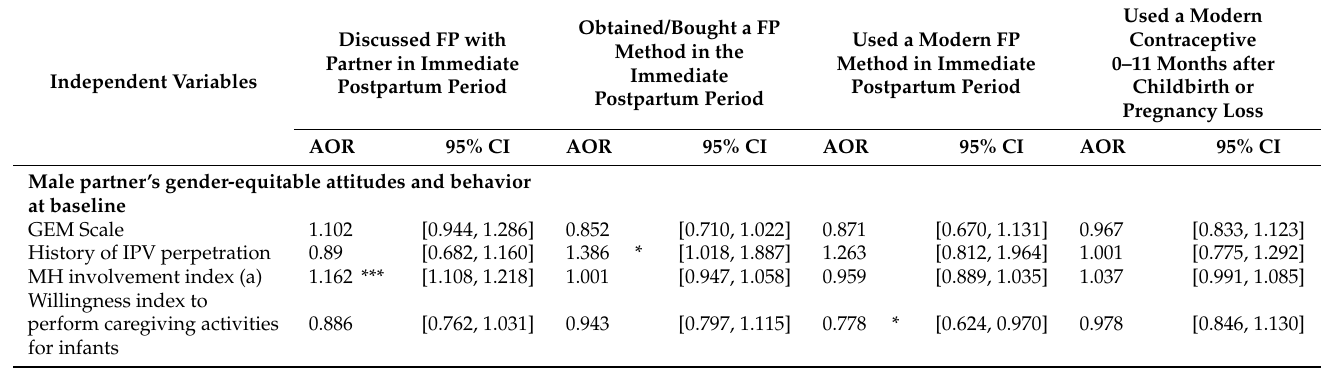
Table 5. Results of logistic regression models for selected postpartum family planning outcomes among first-time mothers age 15–24, with interaction terms between the couple’s marital status and the male partner’s gender-equitable attitudes and behaviors, Kinshasa,